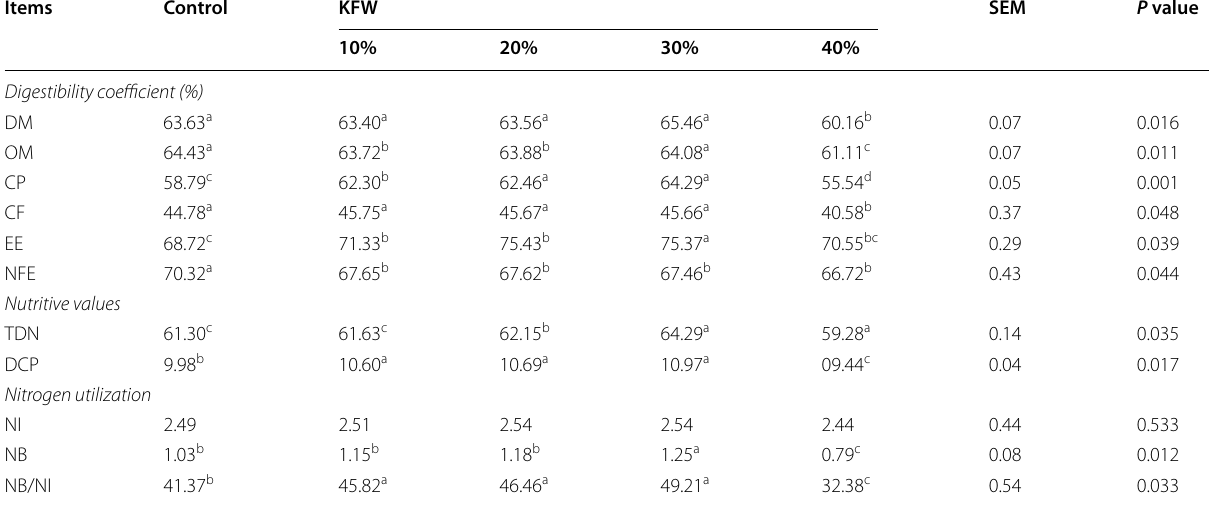
a,b,c Means with different superscripts in the same row differ significantly ( P <